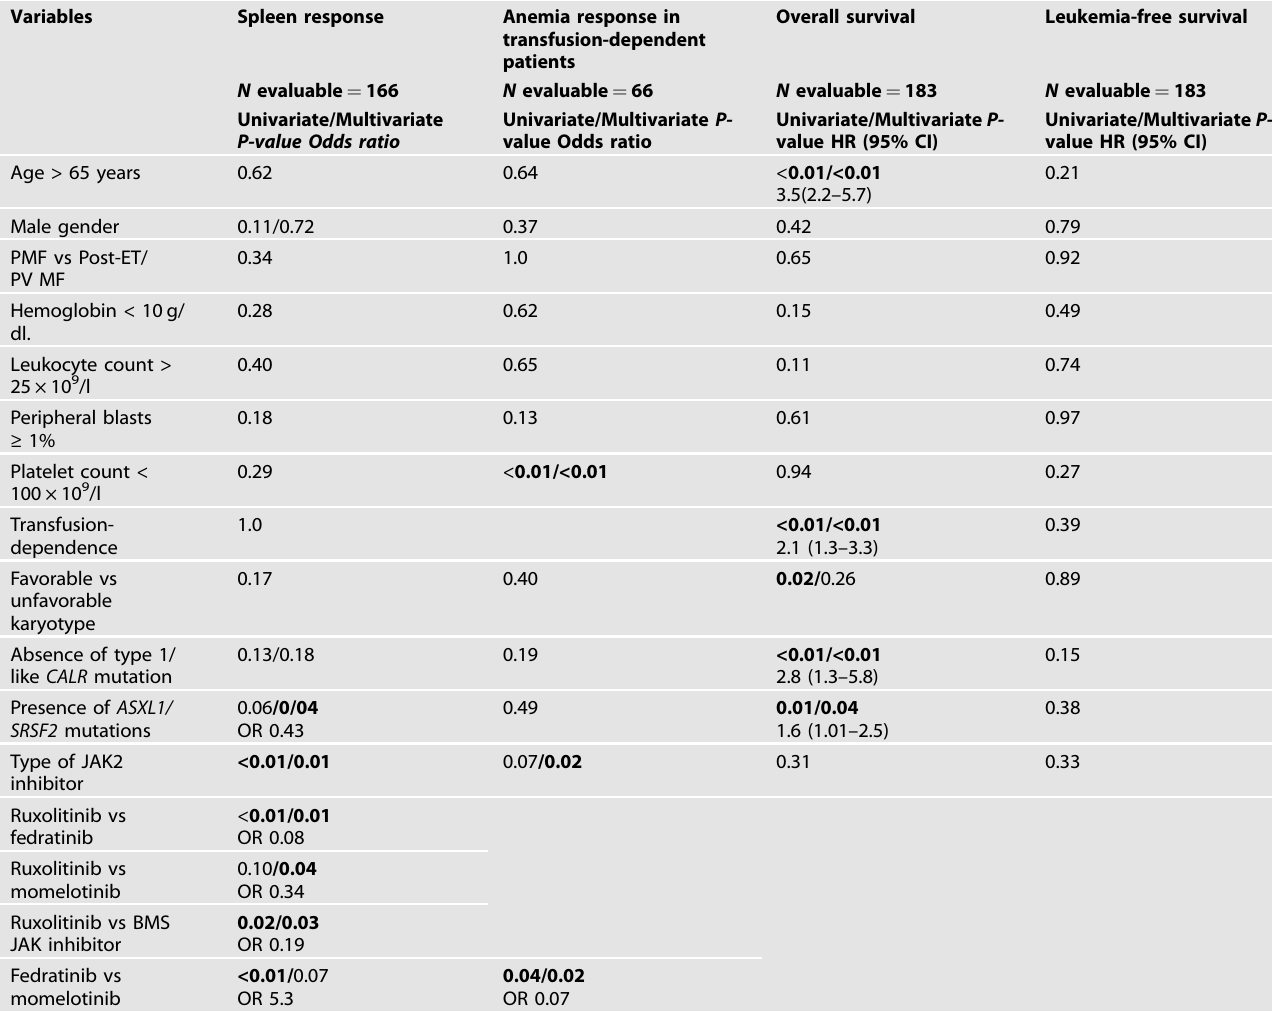
Table 2. Predictors of inferior response and survival in 183 JAK2 inhibitor-naive patients with myelo fi brosis receiving JAK2 inhibitors in the context of clinical